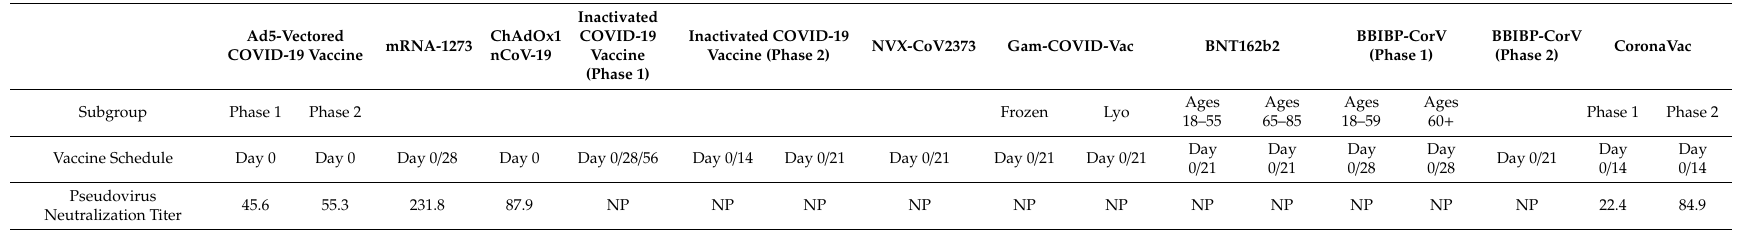
Table 4. Immunogenicity of vaccines as measured by pseudovirus neutralization, SARS-COV-2 neutralization, and microneutralization